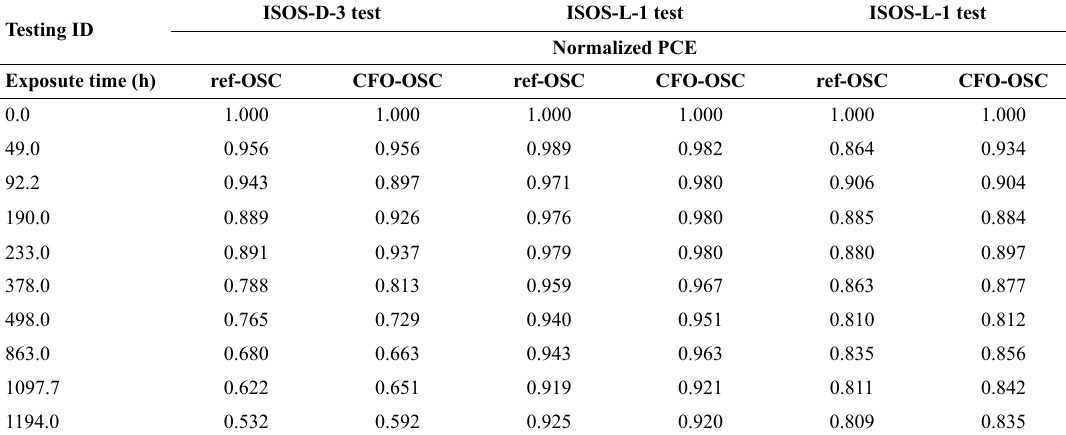
Table 3. Normalized PCE values of ref-OSC and CFO-OSC submitted to ISOS-D-3, ISOS-O-1 and ISOS-L-1